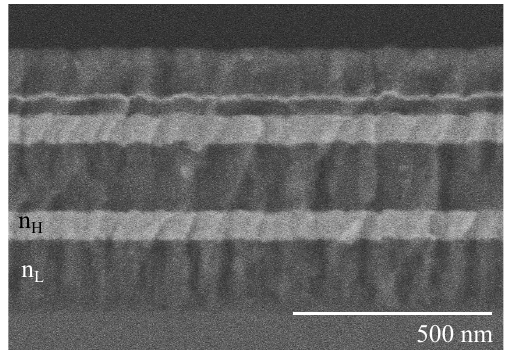
Figure 1. Cross section SEM micrograph of the manufactured